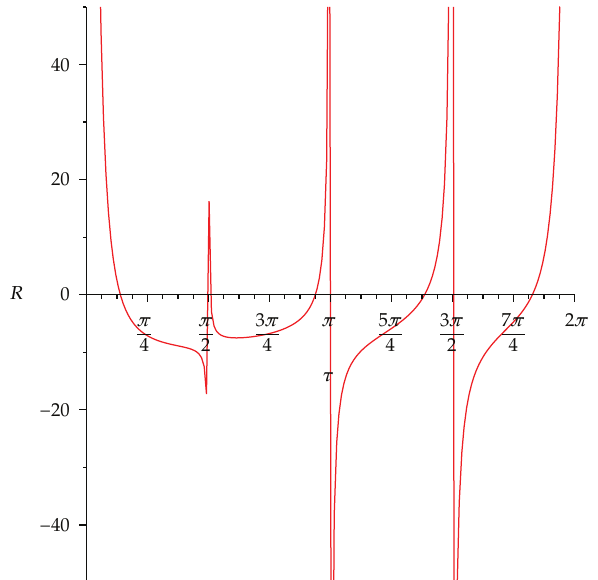
Figure 31: The evolution of the R with respect of the cosmic time τ for (cid:2) 5.20 (cid:3)